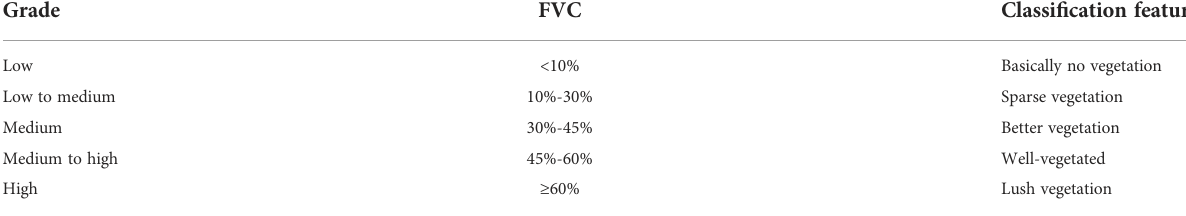
TABLE 1 The classi fi cation standard of